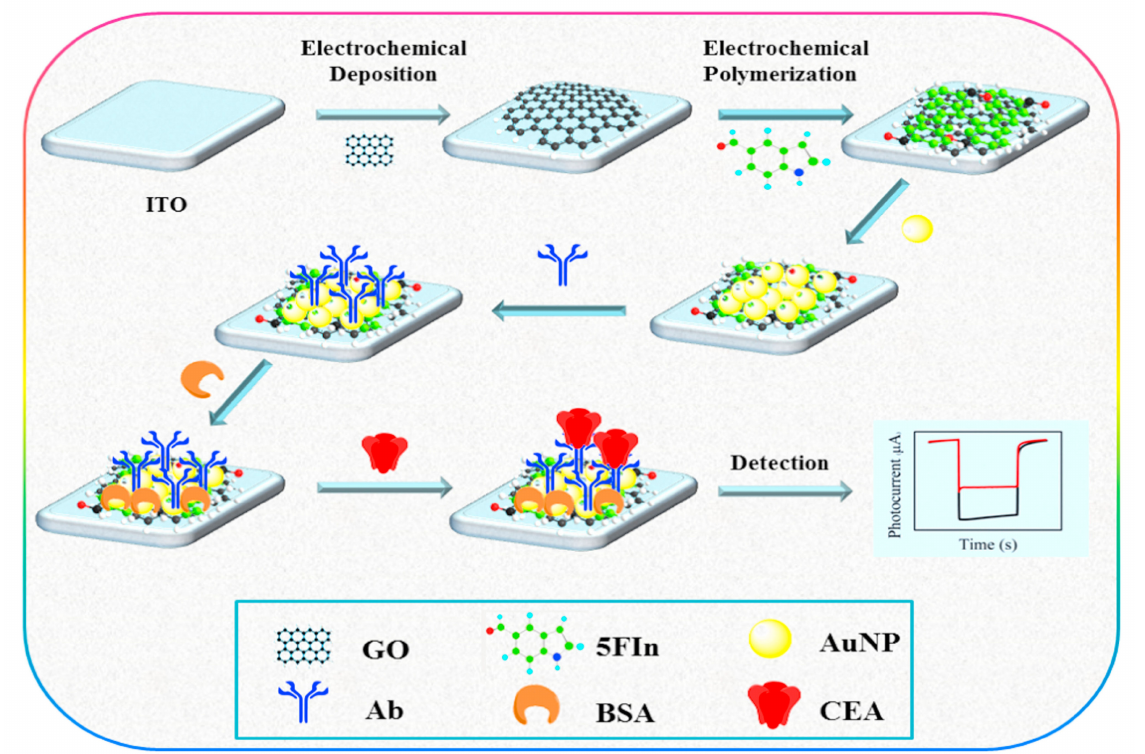
Figure 20. The construction steps in P5FIn/erGO based PEC immunosensor. GO: graphene oxide; Ab: antibody; P5Fln: poly (5–formylindole); 5Fln: 5–formylindole. Reprinted with permission from [135], published by Elsevier,